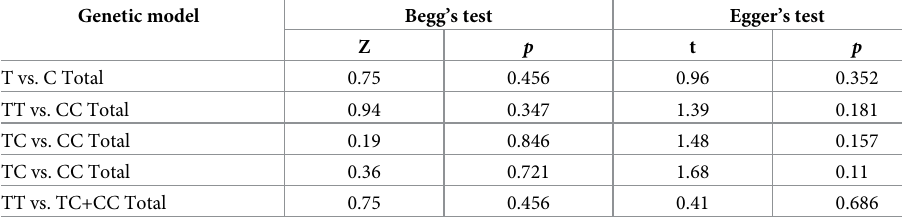
Table 3. The publication bias in the meta-analysis. Genetic model